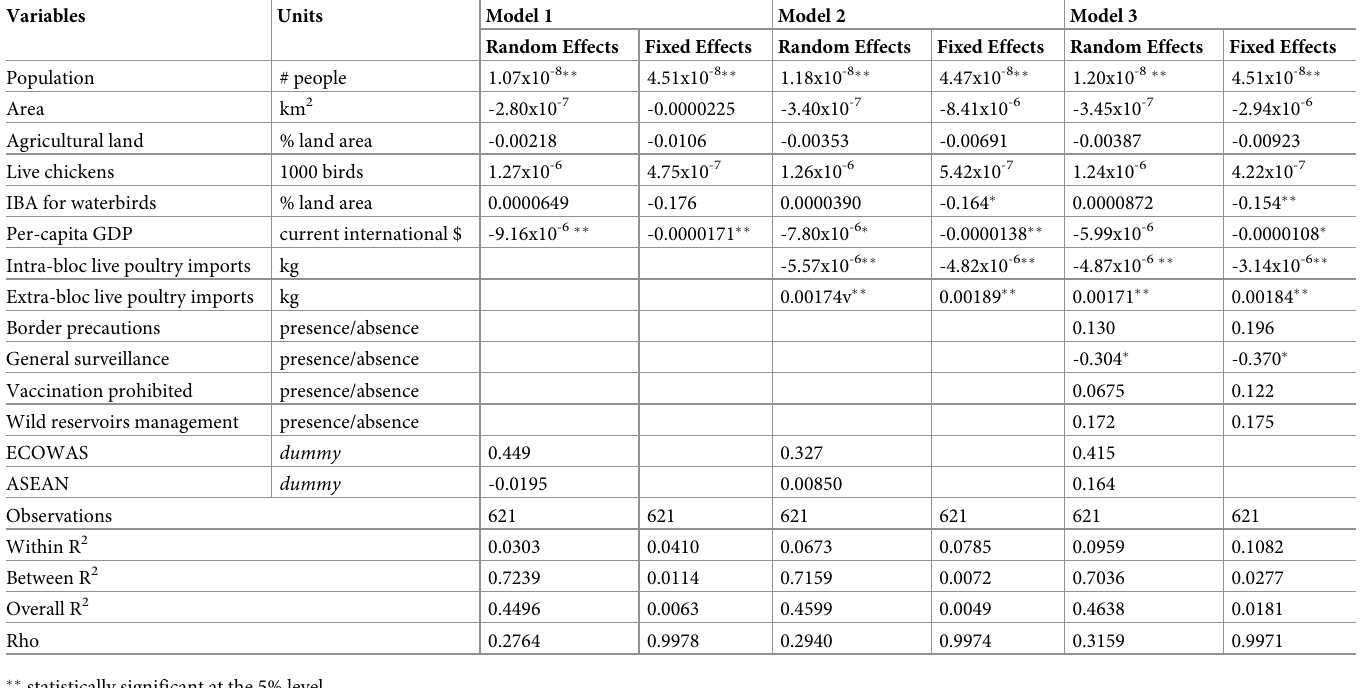
Table 2. Results from the regression models of H5N1 outbreak risk factors for member states in all three regions; regressor coefficients are reported and statisti- cally-significant factors are marked by asterisks. A blank space signifies that the variable was not included in the given